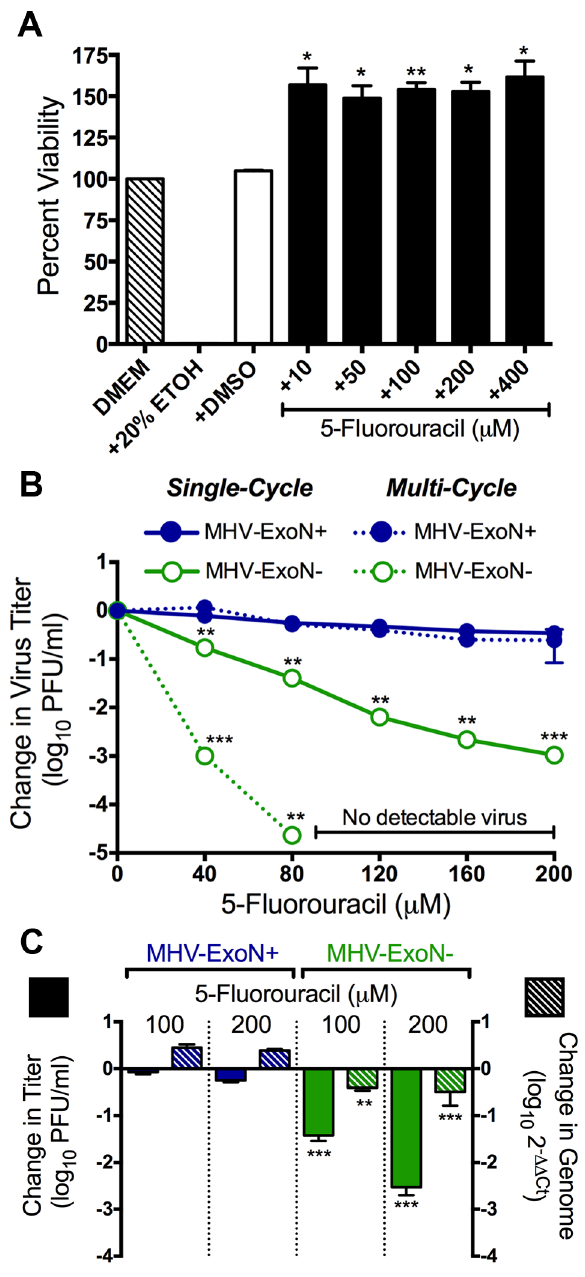
Figure 2. The increased sensitivity of MHV-ExoN 2 viruses to 5- FU is consistent with mutagenesis. ( A ) DBT cells in 96-well plates were incubated with DMEM alone, or DMEM containing 20% ethanol (EtOH), 4% DMSO, or the indicated concentration of 5-FU for 12 h. Cell viability was determined using CellTiter-Glo (Promega) according to manufacturer’s instructions. All values were normalized to the untreated (DMEM) control. Mean values 6 S.E.M. are shown, n=2. ( B ) MHV-ExoN + (filled circle) and MHV-ExoN 2 (open circle) virus sensitivity to 5-FU during single- (solid lines; MOI=1 PFU/cell) and multi-cycle (dotted lines; MOI=0.01 PFU/cell) replication. MHV-ExoN + viruses are shown in blue and MHV-ExoN 2 viruses are shown in green. The change in virus titer was calculated by dividing virus titers following treatment by the untreated controls. Mean values 6 S.E.M. are shown, n=4. ( C ) The change in titer (filled bars) and genomic RNA levels (hatched bars) of MHV-ExoN + (blue) and MHV-ExoN 2 (green) viruses following treatment with 5-FU is shown. DBT cells were infected with MHV- ExoN + or MHV-ExoN 2 in the presence or absence of 5-FU, and